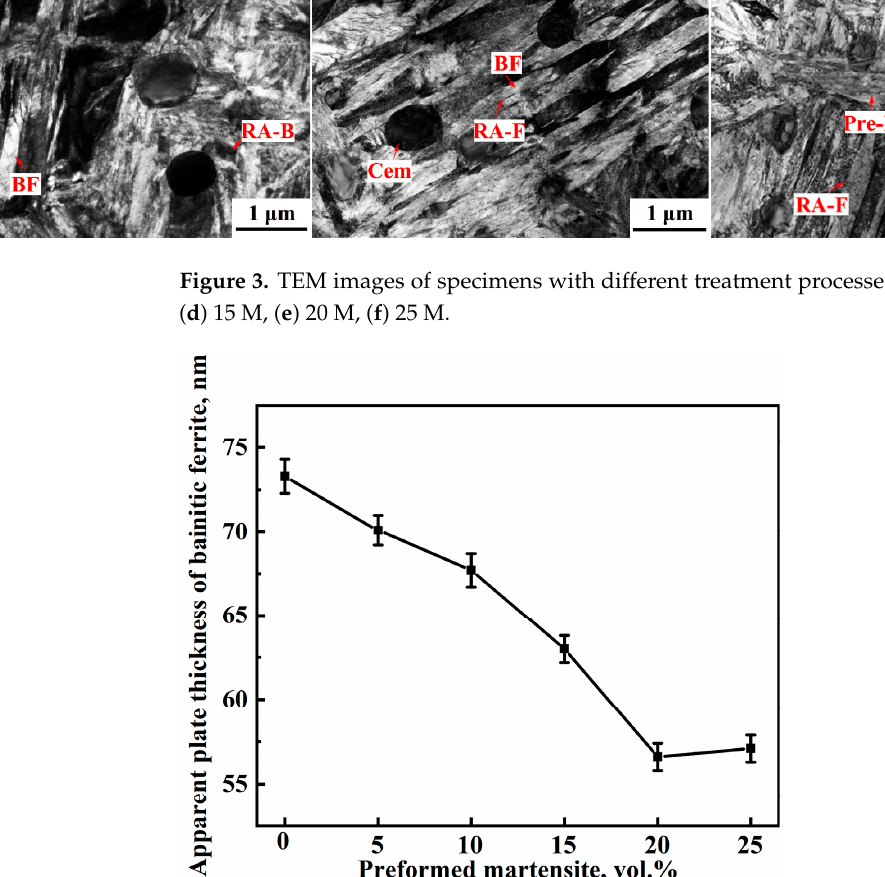
Figure 4. Apparent plate thickness of bainitic ferrite of specimens with different treatment processes. Note: For each specimen, about 400 measurements were conducted on multiple TEM images to obtain statistically representative results